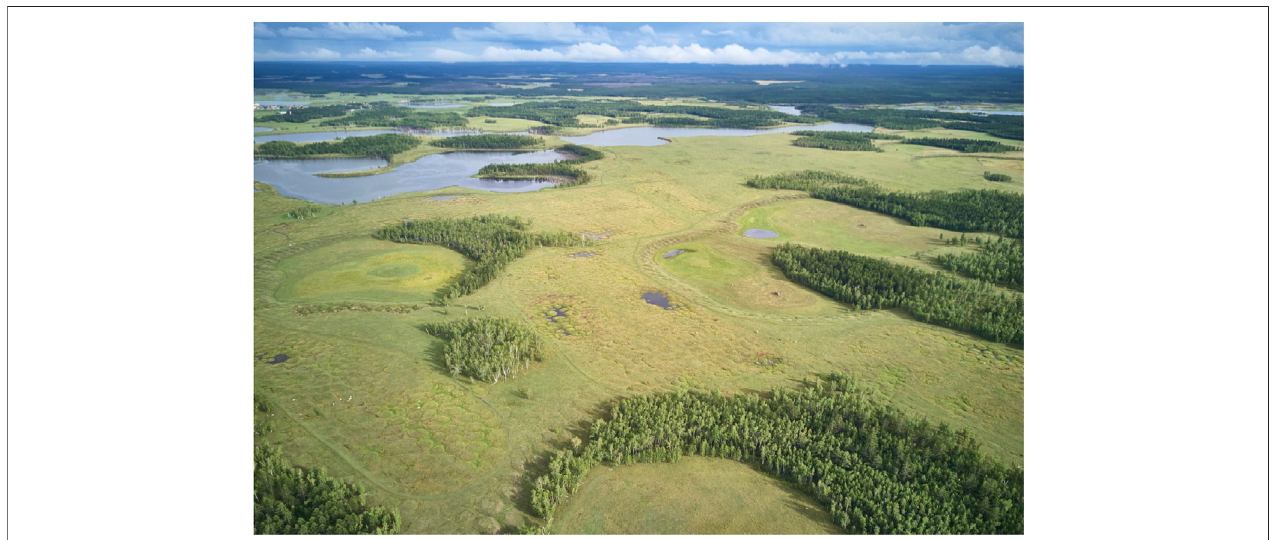
FIGURE 3 | The initial stage of thermokarst degradation of the soil cover of abandoned arable land in the area of Churapcha with typical Yedoma-alas landscape. Photo by K. Abrosimov.